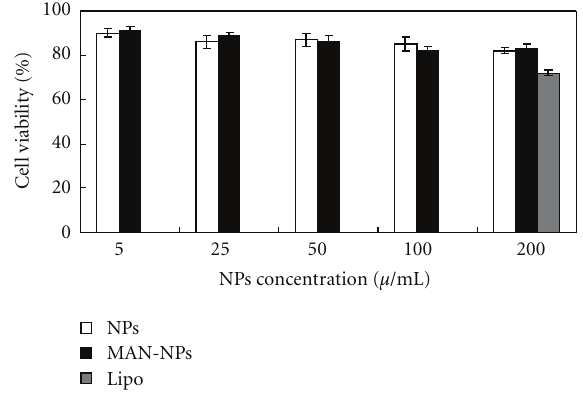
Figure 4: Cell viabilities of MAN-DNA-NPs and DNA-NPs (mean ± SD, n = 3). MAN-NPs and NPs at various concentrations (5, 25, 50,